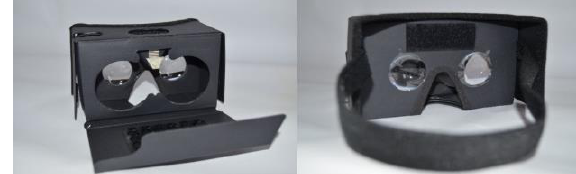
Figure 1. Google Cardboard Splaks 3D